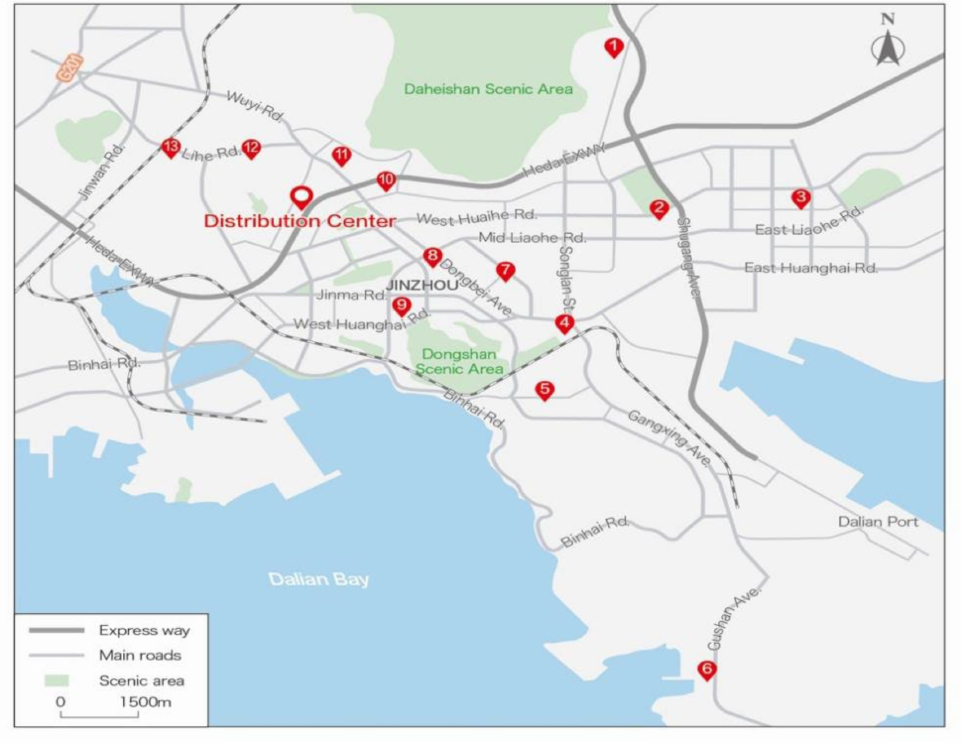
Figure 9. TheR Distribution center customer